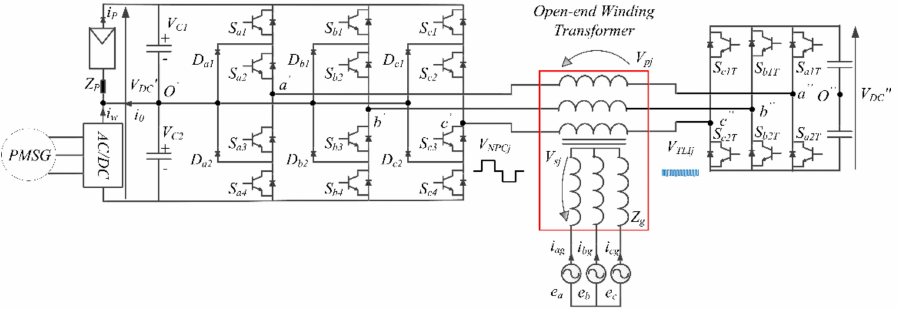
Figure 2. Six-level MMC (three-level inverter (3LI) + two-level inverter (TLI)) with two energy sources.